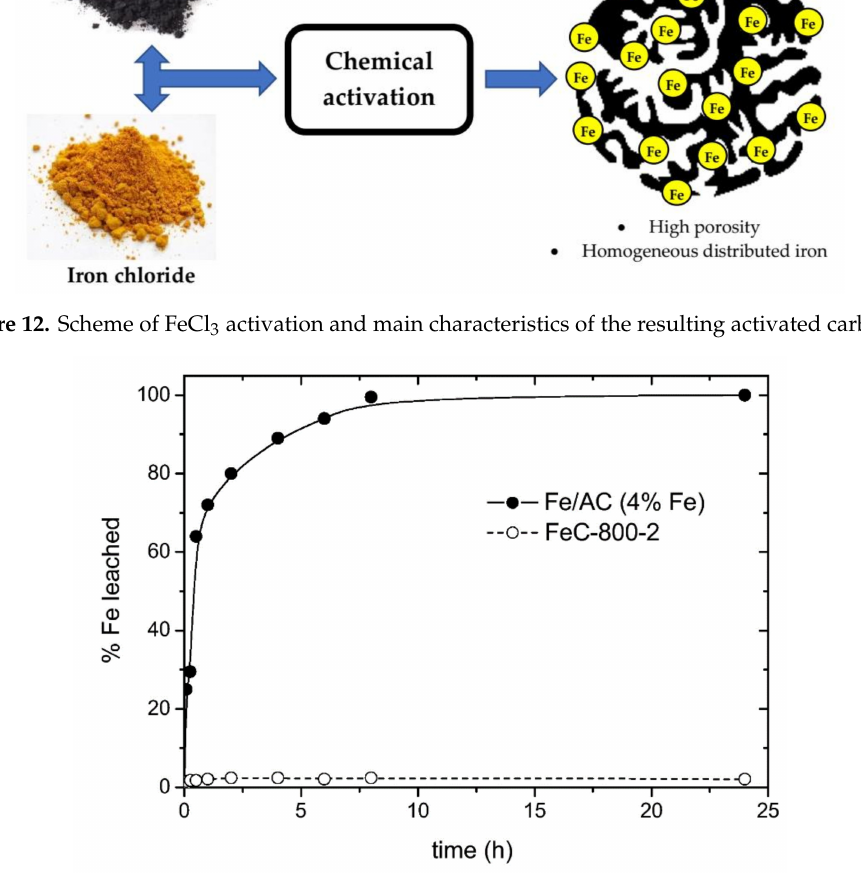
Figure 13. Comparison between the stability of the FeCl 3 -derived activated carbon catalyst (FeC-800-2) and activated carbon with iron deposited by the incipient wetness procedure (Fe / AC) (reprinted from [56] with permission of Elsevier,